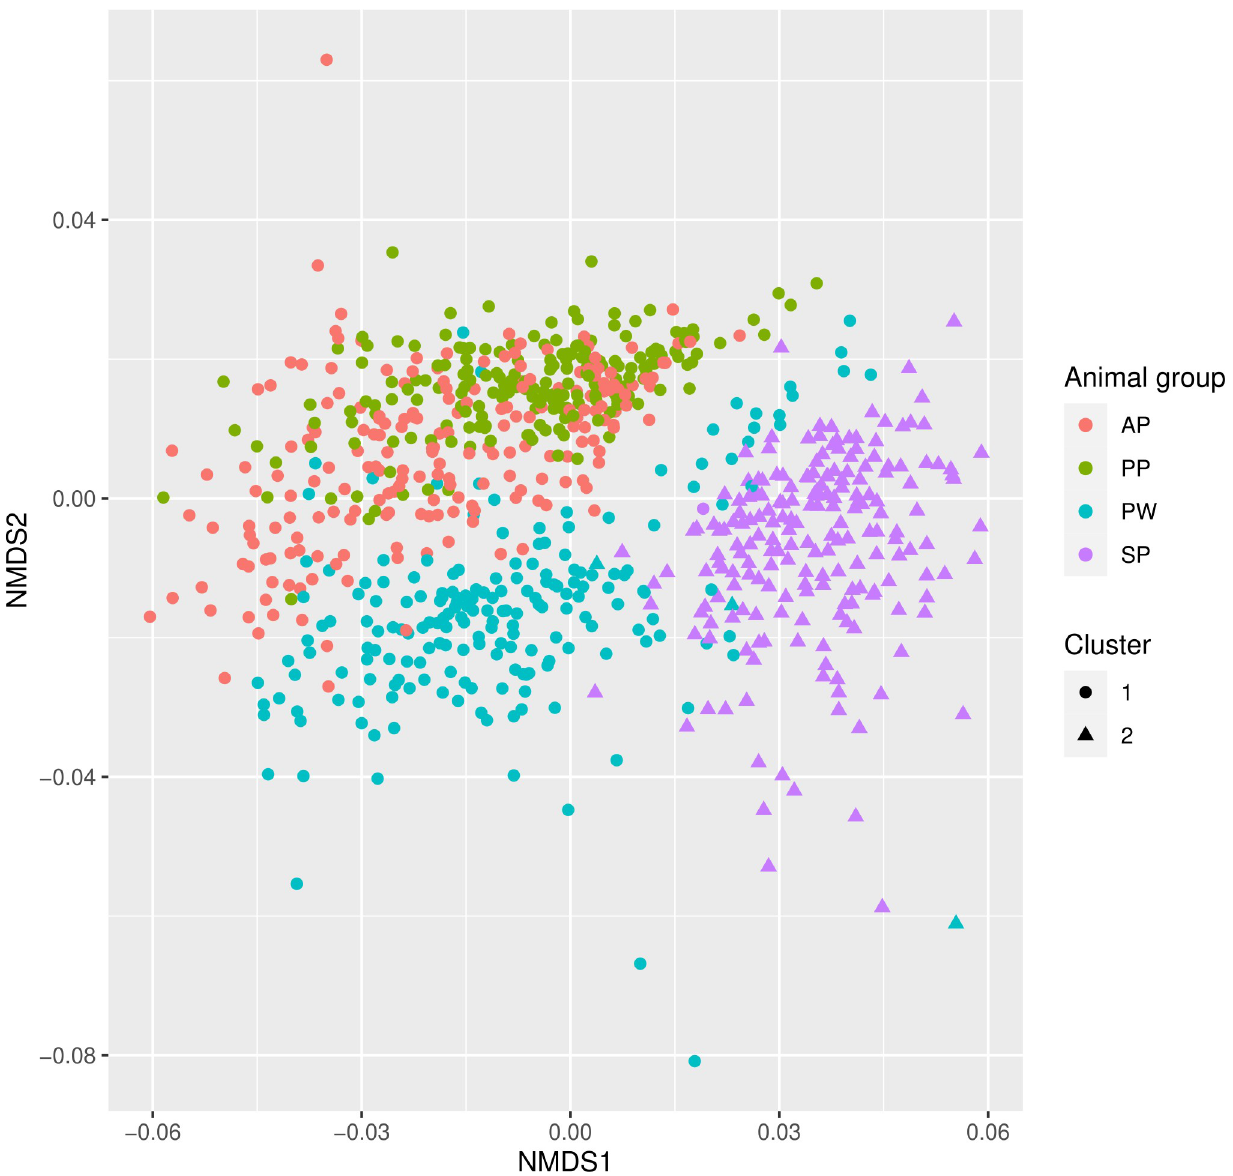
Fig 2. NMDS and hierarchical clustering of different animal groups. AP = sows antepartum, PP = sows postpartum, SP = suckling piglets, PW = post- weaning piglets. Filled circles and filled triangles visualize different cluster formation according to the optimal cluster formation method (S1 Fig).